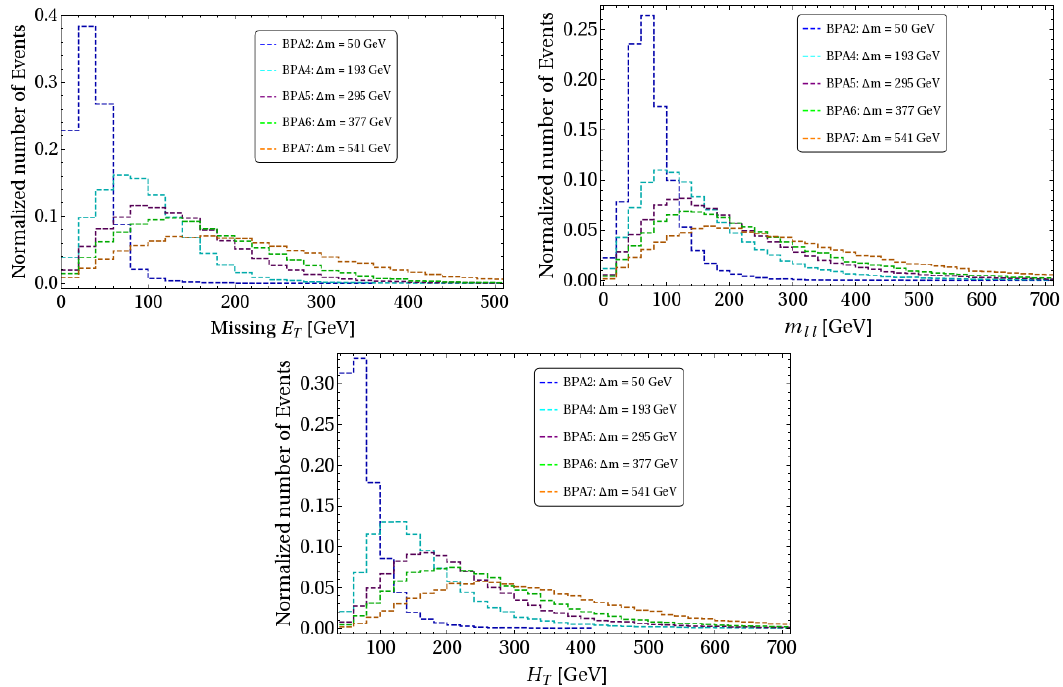
Figure 20 . Missing energy ( =E T ), invariant mass of dilepton ( m ‘‘ ) and e(cid:11)ective mass ( H T ) distri- butions of ‘ + ‘ (cid:0) + ( =E T ) events from signal at LHC are shown at p s = 14 TeV. We have chosen di(cid:11)erent values of (cid:1) m corresponding to di(cid:11)erent benchmark points as indicated in table